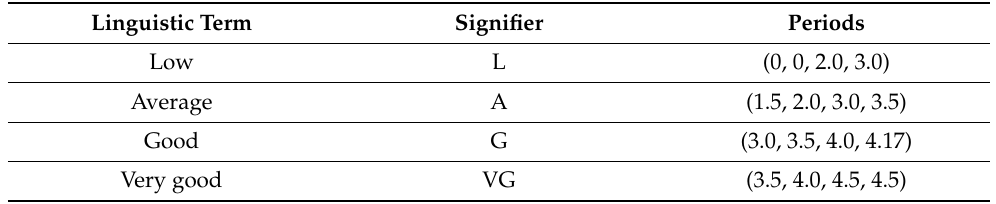
Table 2. Fuzzy set of inputs GPA Result.